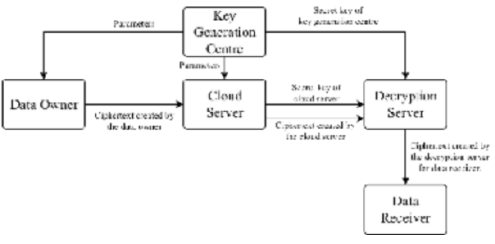
Figure 4. Key management in CP-ABE for IoT healthcare